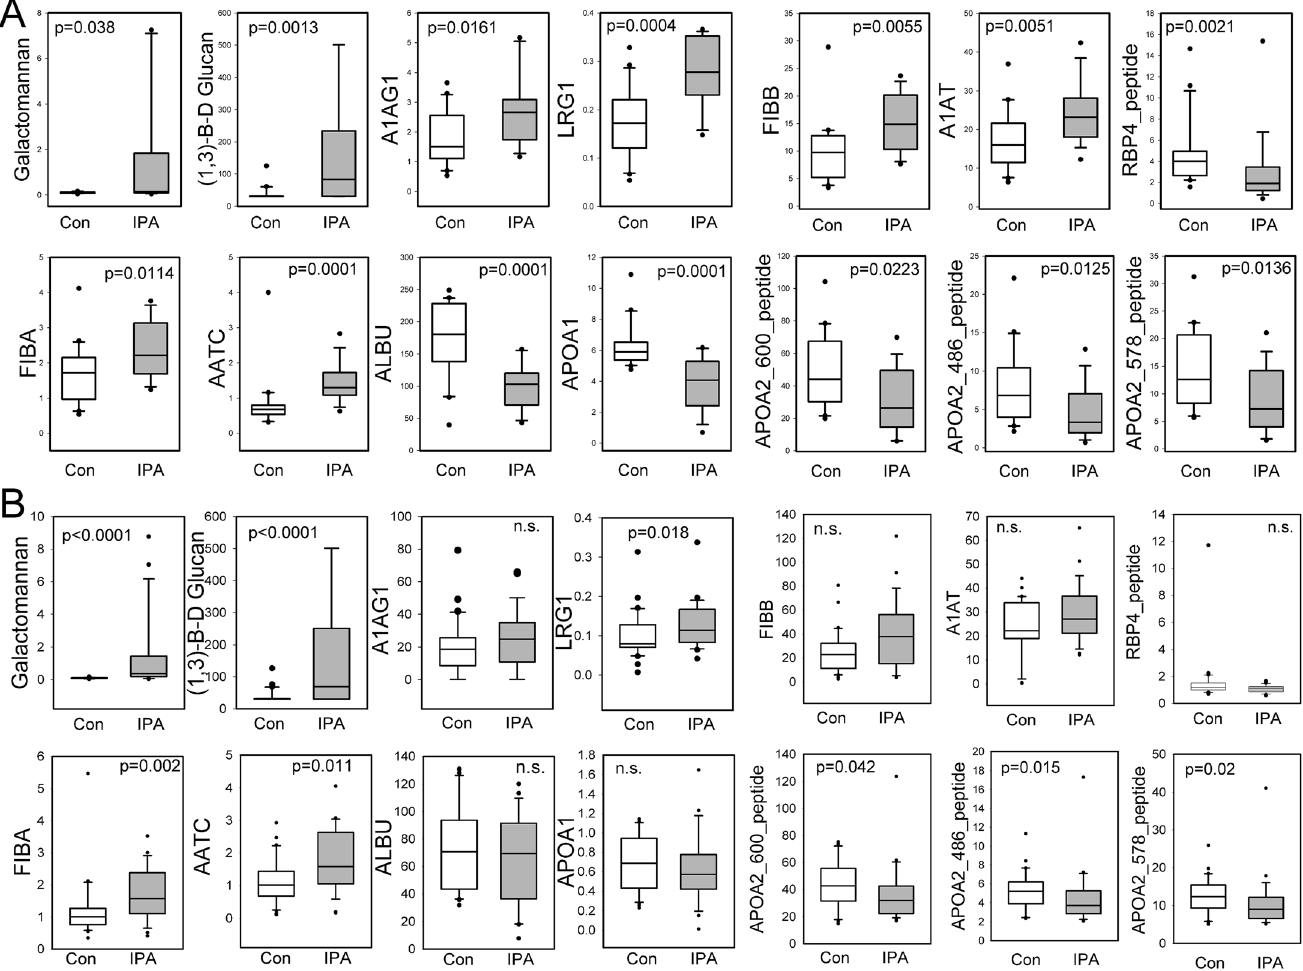
Fig 3. SID-SRM-MS measurements of candidate biomarkers in IPA. A). SID-SRM-MS measurements of the discovery cohort. For each candidate biomarker, the SID-SRM-MS measurements by disease category are shown. Box plots show the 25% and 75% interquartile range and the median value, indicated by horizontal dark line. Outliers are signified with circles. Note that the median horizontal line is not symmetrically located within the box plot, signaling that the data are not normally distributed. P values are from Wilcoxon ranked sum. B). SID-SRM-MS of the validation cohort. Data are presented as in Panel